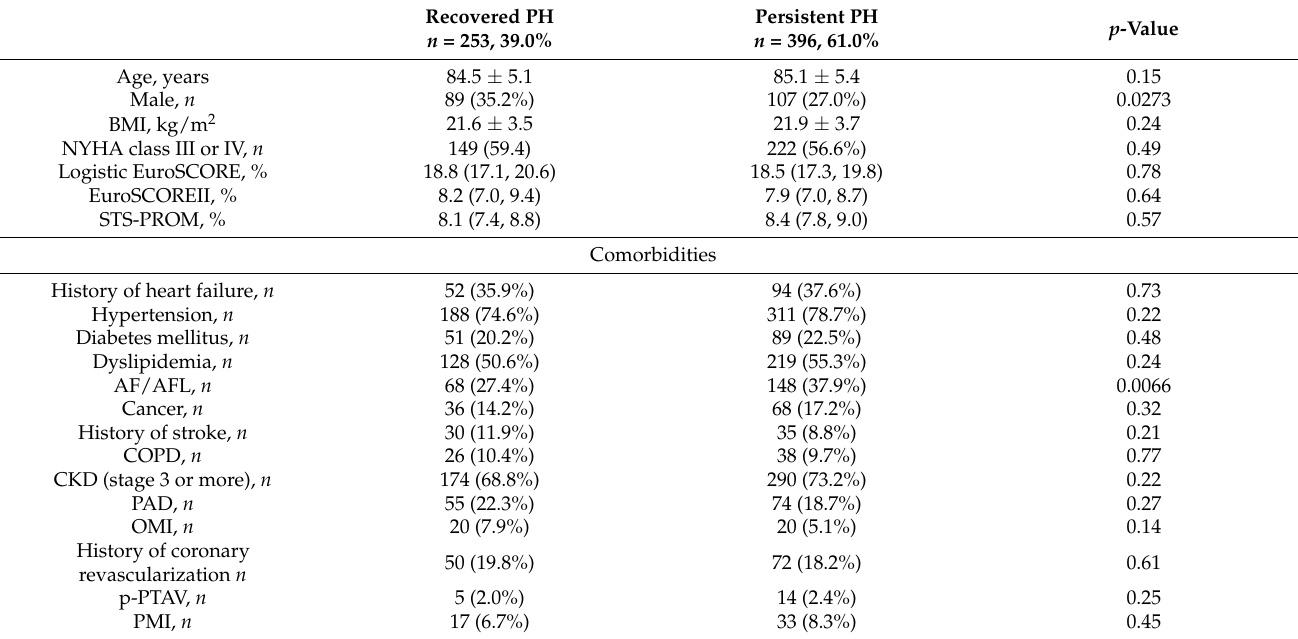
Table 2. Baseline characteristics of Recovered vs. Persistent PH